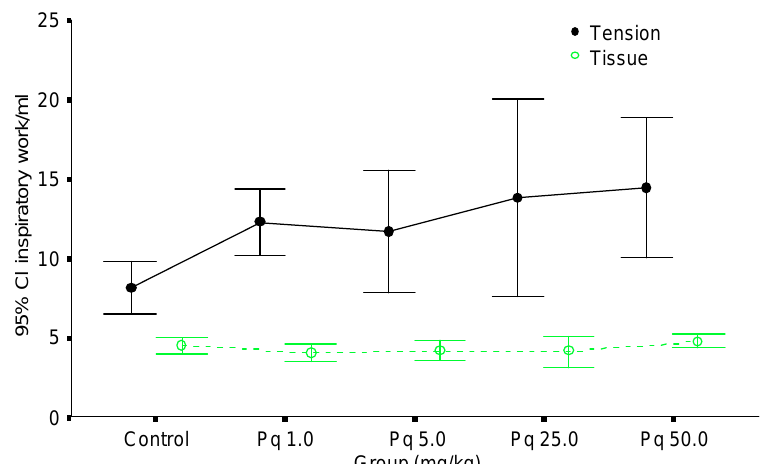
Figure 4 - Mean values (circles) and corresponding standard errors (lines) of the 95% confidence interval (CI) of inspiratory work attributable to surface tension and tissue forces in control animals and in animals submitted to different doses of paraquat (Pq) intoxication.